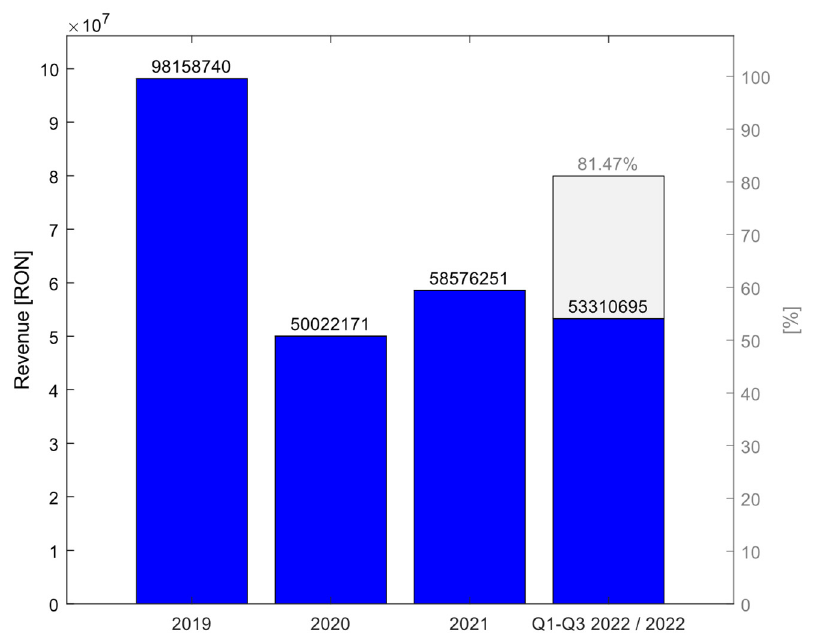
Figure 6. Hospitals revenues between 1 January 2019 and 1 September 2022 .